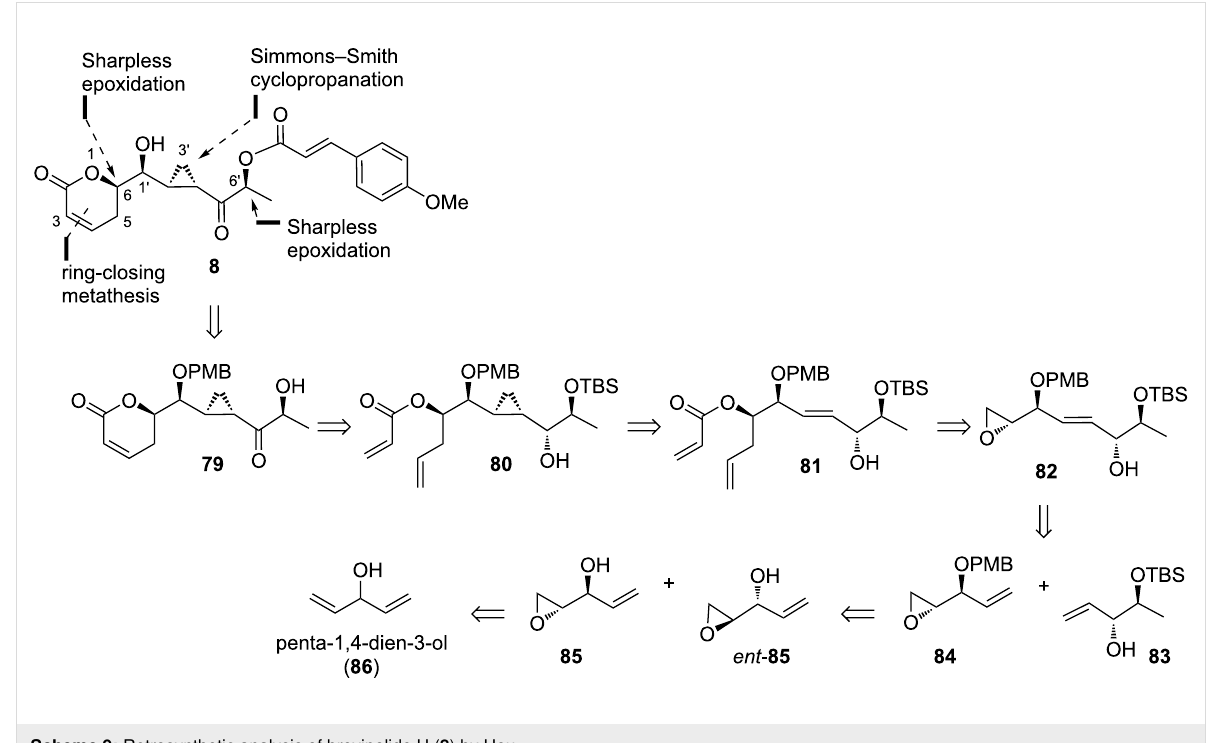
Scheme 9: Retrosynthetic analysis of brevipolide H ( 8 ) by